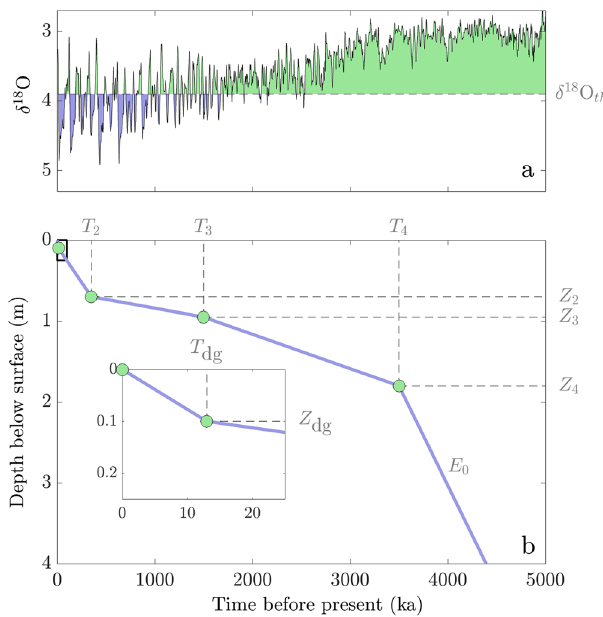
Fig. 2 Schematic of the forward model parameters. Schematic illustrating the ten model parameters. a The exposure histories are de fi ned from a stacked global benthic δ 18 O record 23 in combination with a modeled glaciation threshold parameter ( δ 18 O th ), dividing periods of glacial cover (blue) from periods of surface exposure (green). Note that we start all models at 15 Ma, but here only show the last 5 Myr for visibility. b The exhumation histories are parameterized using a series of modeled time (T 2 , T 3 , T 4 ) - depth (Z 2 , Z 3 , Z 4 ) tie points. The inset shows expanded scale around timing of last deglaciation (T dg ) and the corresponding depth (Z dg ). The fi nal model parameter (E 0 ) is a constant erosion rate determining the exhumation path from the initiation of each model run at 15 Ma until T 4 .